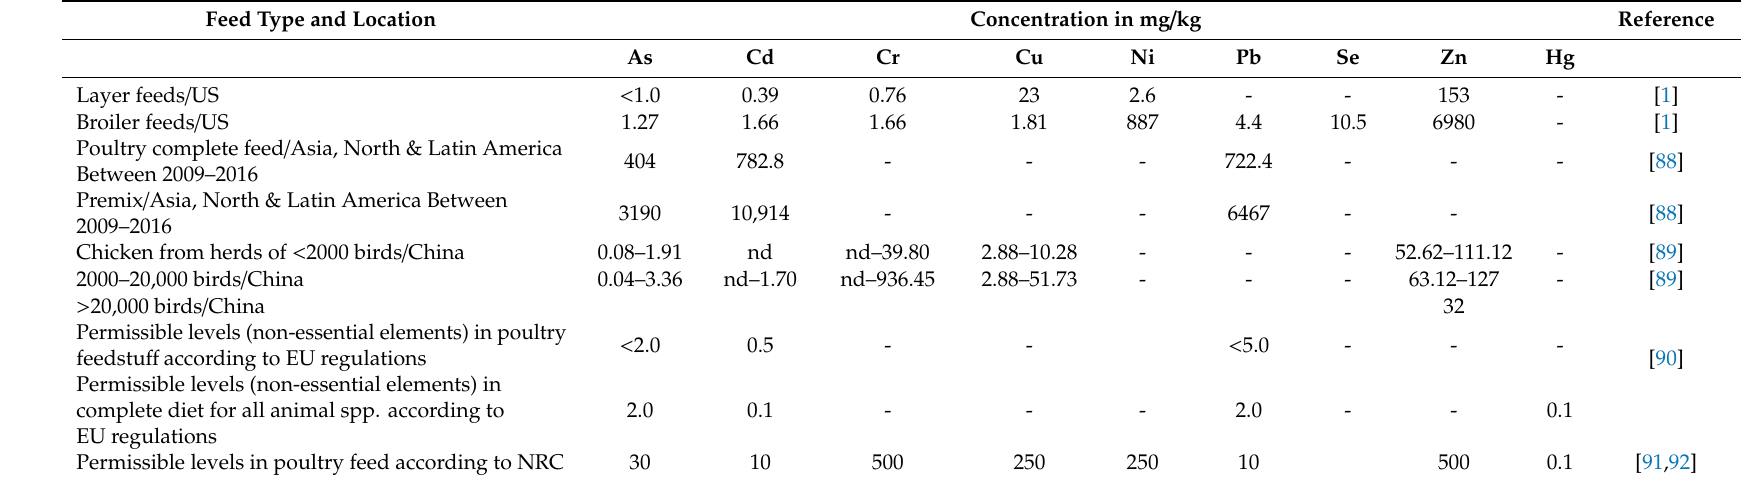
Table 8. Heavy metal concentration in chicken feeds of the US and permitted levels according to European Union (EU) and National Research Council (NRC)